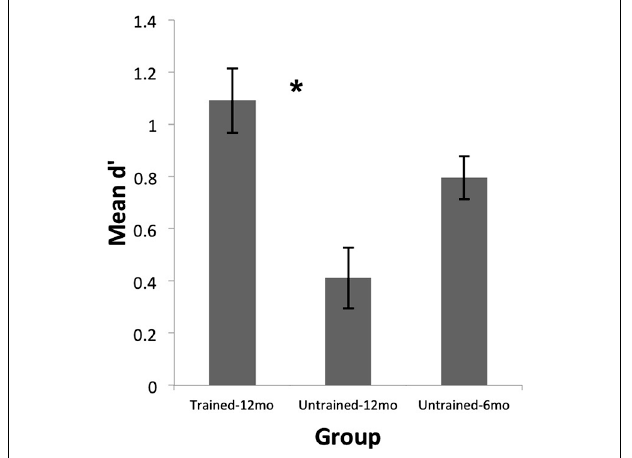
FIGURE 2 | Rhesus monkey voice discrimination abilities of 12-month-old infants ( n = 24) who received monkey-voice training (Trained-12 month) in the present study compared to 6- (Untrained-6 month) and 12-month-old (Untrained-12 month) infants ( n = 24 each) who did not receive training and were tested in a previous study (Friendly etal., 2013). Discrimination was much better for trained than untrained 12-month-old infants (* p < 0.001).Trained 12-month-olds also preformed slightly better ( p = 0.05) than untrained 6-month-old infants, suggesting that 2 weeks of exposure to monkey voices at 12 months reinstates processing of foreign-species voices to a level observed at 6 months, or better, before perceptual narrowing is fully underway. Error bars represent